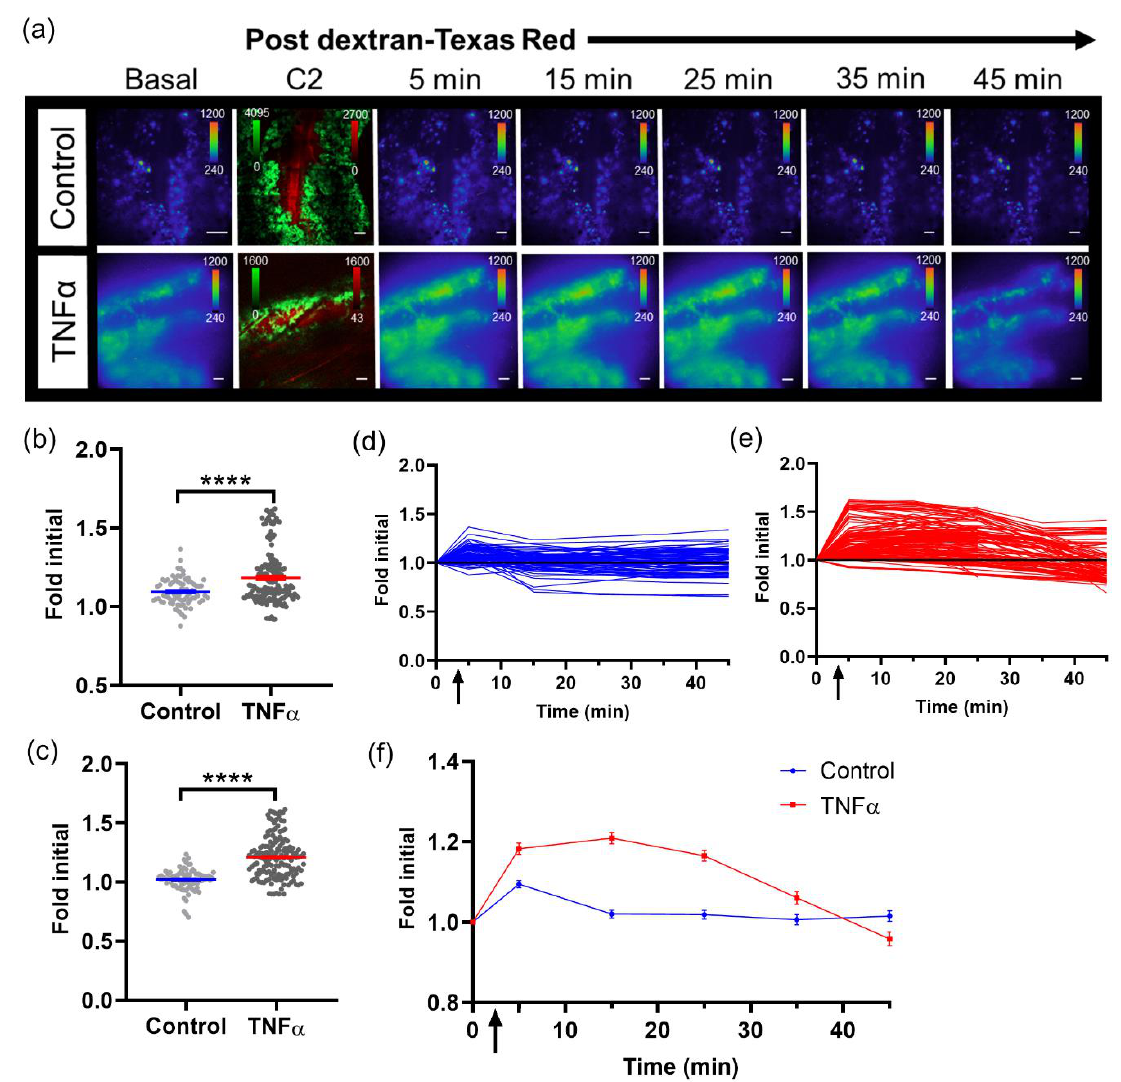
Figure 3. Imaging single tumor cell signaling dynamics in vivo. ( a ) Representative in vivo microscopic images over time of NF- κ B transcriptional activation by TNF α in B16F10 κ B5-FLuc GFP reporter tumor cells in skin window chamber-bearing animals; 10X magnification; BLI, 10 min acquisition, open filter; Confocal imaging (C2), 4.8 speed, laser lines: 488 nm (GFP, tumor) and 561 nm (dextran-Texas Red, vasculature); scale bar represents 100 µ m. BLI images showing NF- κ B activation were obtained prior to and following dextran-Texas Red i.v. injection without (control, n = 3 animals) or with TNF α ( n = 4 animals) at multiple time points (Basal, 5, 15, 25, 35, 45 min), while confocal image (C2) confirms presence of tumor cells (GFP, green) and successful i.v. administration of dextran-Texas Red (red). Quantification of changes in bioluminescence, indicative of changes in NF- κ B transcriptional activation, following dextran alone or with TNF α administration at ( b ) 5 min and ( c ) 15 min (**** p < 0.0001). Quantification of bioluminescence changes over time in individual tumor cells in animals administered ( d ) dextran, or ( e ) dextran with TNF α . ( f ) Quantification of mean NF- κ B transcriptional activation within tumor cells over time in vivo (data are represented as mean ± SEM); black arrow indicates when dextran alone or dextran with TNF α were